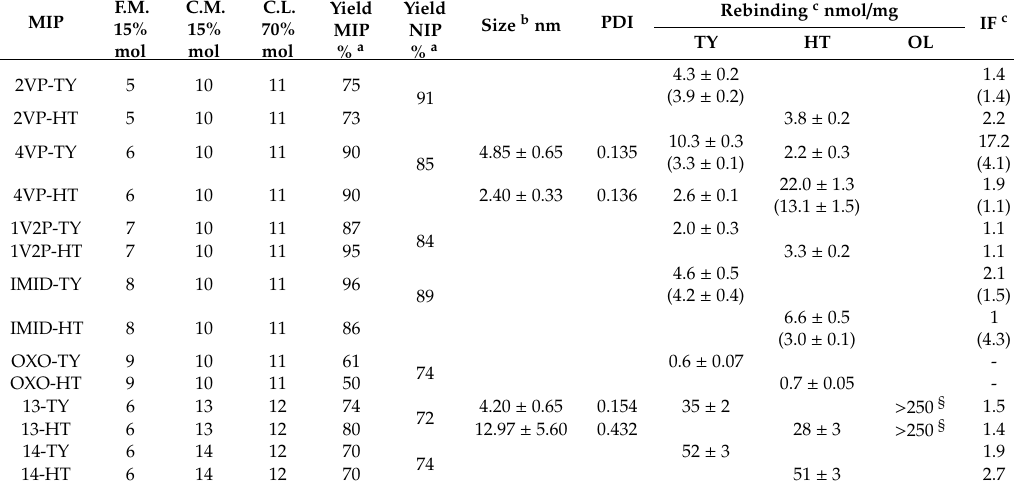
Table 2. Characterization of the imprinted materials.